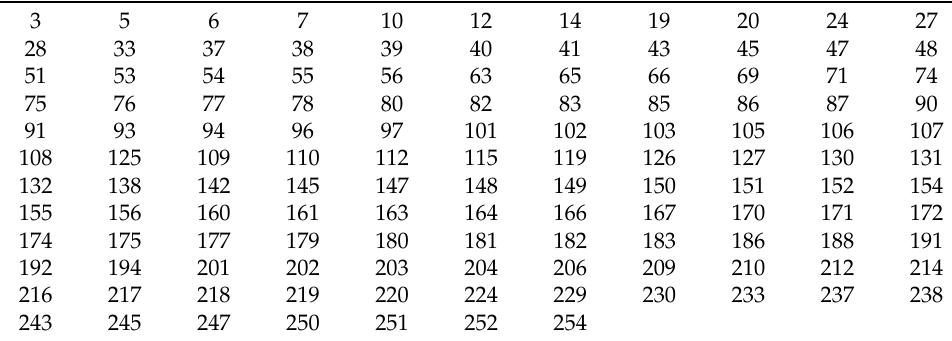
Table 1. The generator list of the prime number 257.